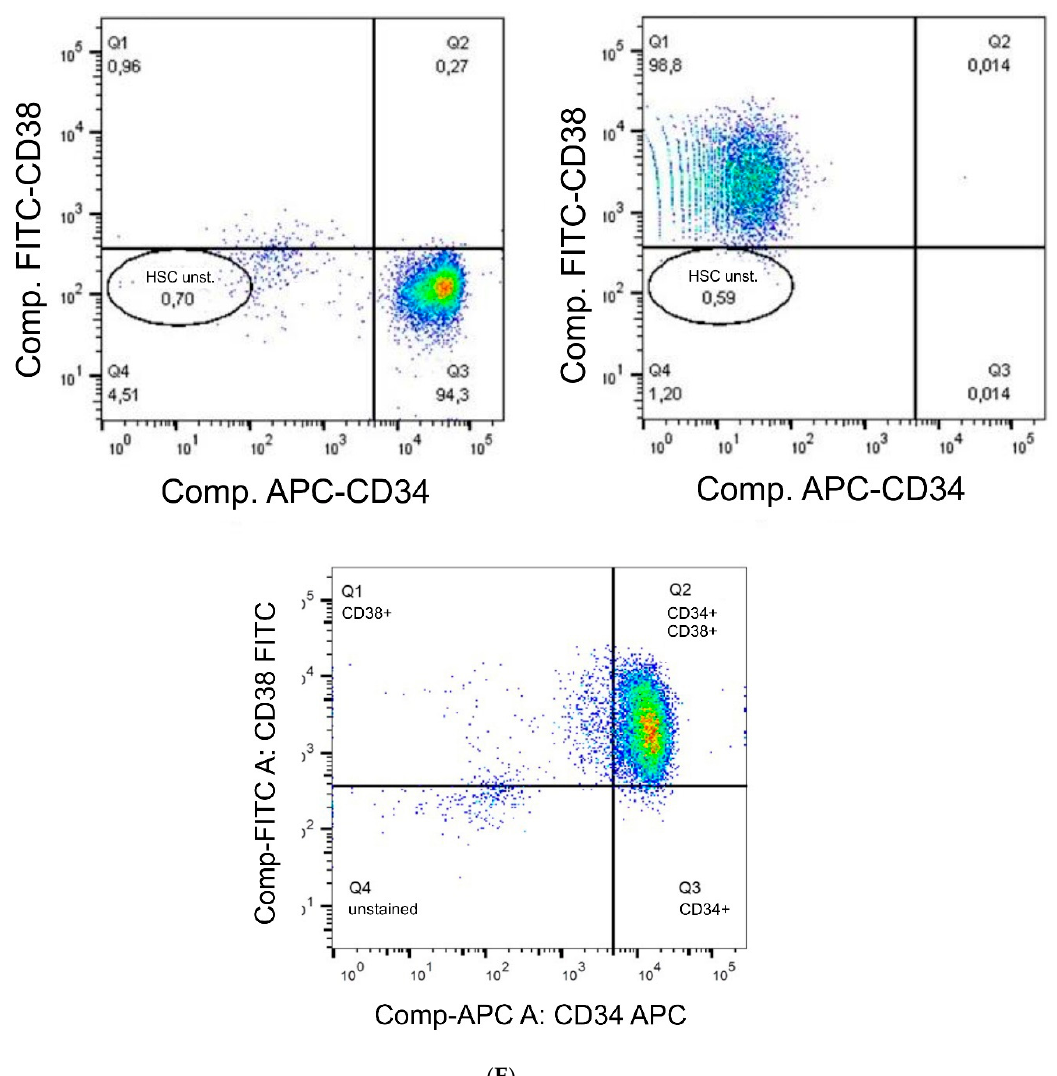
Figure 2. ( A ) Gate set for the isotype control of the CD34 mouse anti-human APC-labelled antibody. ( B ) Gate set for CD34 mouse anti-human APC-labelled antibody. ( C ) Gate set for the isotype control of the CD38 (HIT2)–FITC-labelled antibody. ( D ) Gate set for the CD38 (HIT2)–FITC-labelled antibody. ( E ) Detection of single (CD34 + or CD38 + ) and double positive (CD34 + CD38 + ) stained cells. HSC unst. = unstained hHSC.